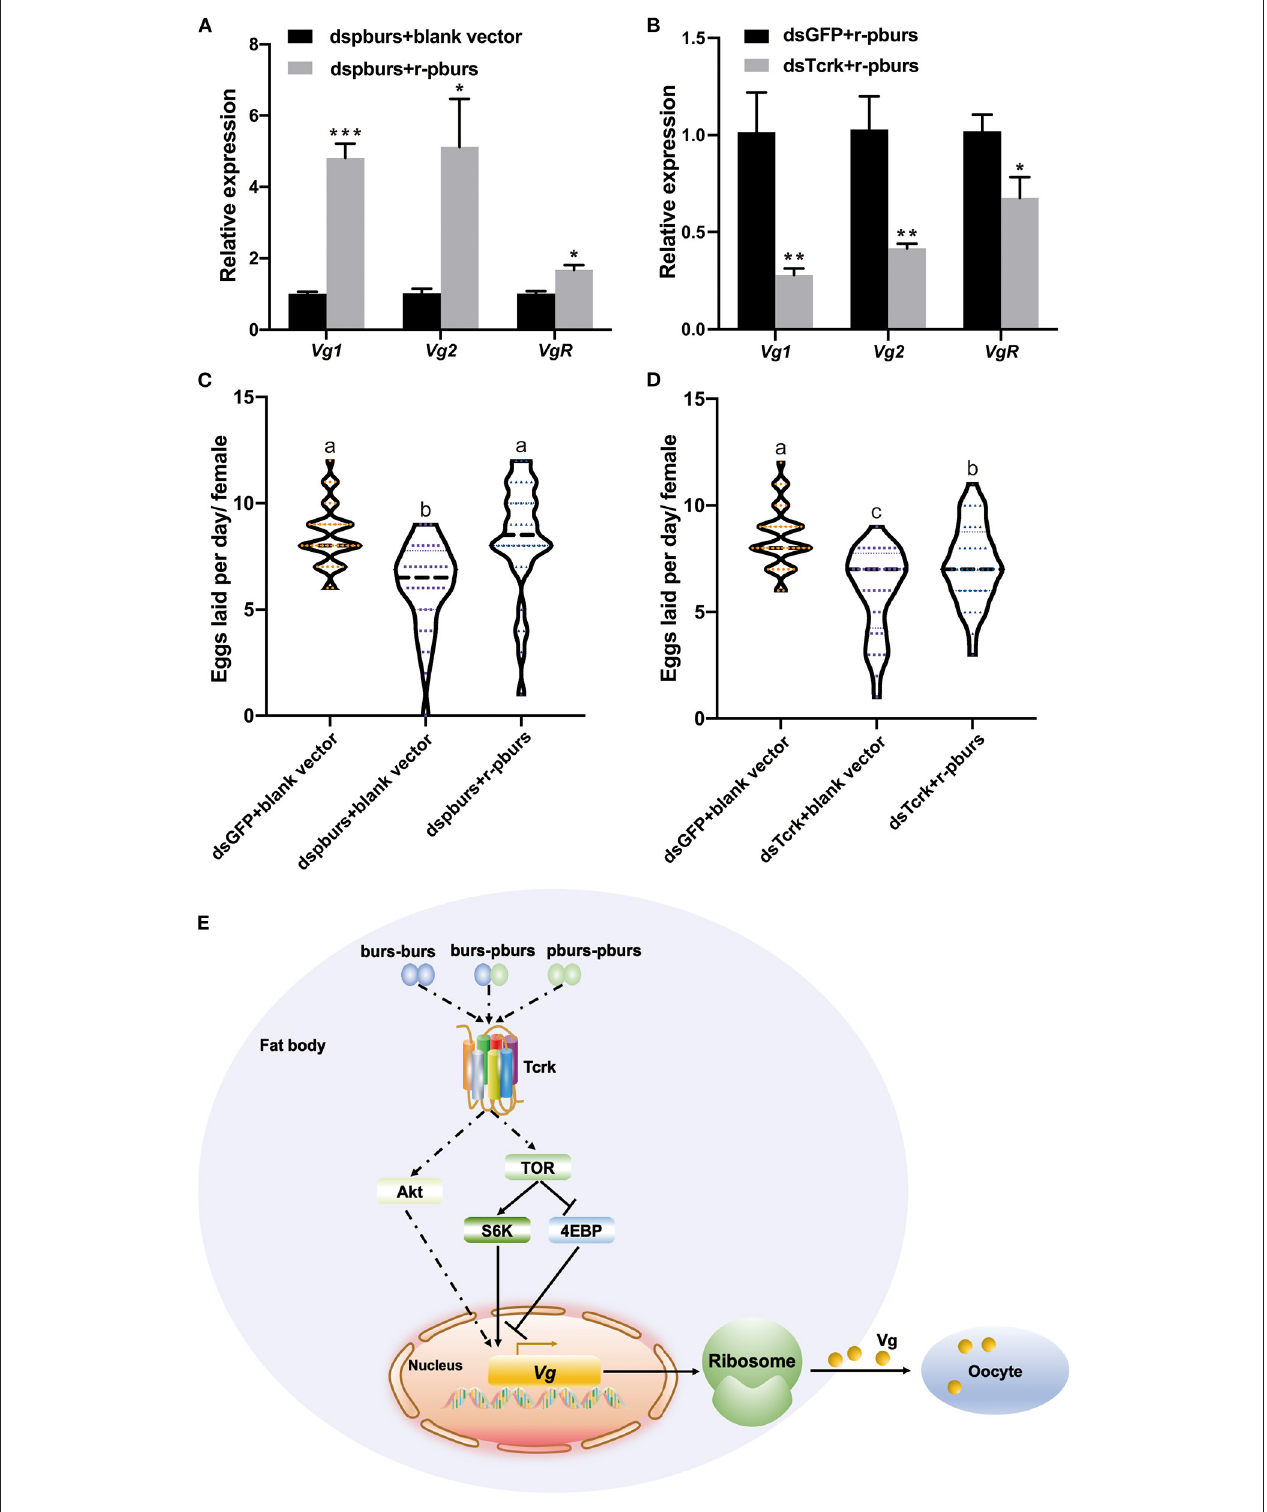
FIGURE 8 | Effects of r-pburs protein on Vg-related genes and egg production in dspburs- or dsTcrk-treated females and a hypothetical model of bursicon (burs) signaling pathways related to Vg expression in Tribolium castaneum . The relative expression of Vg1 , Vg2 , and VgR in (A) dspburs- or (B) dsTcrk-treated females